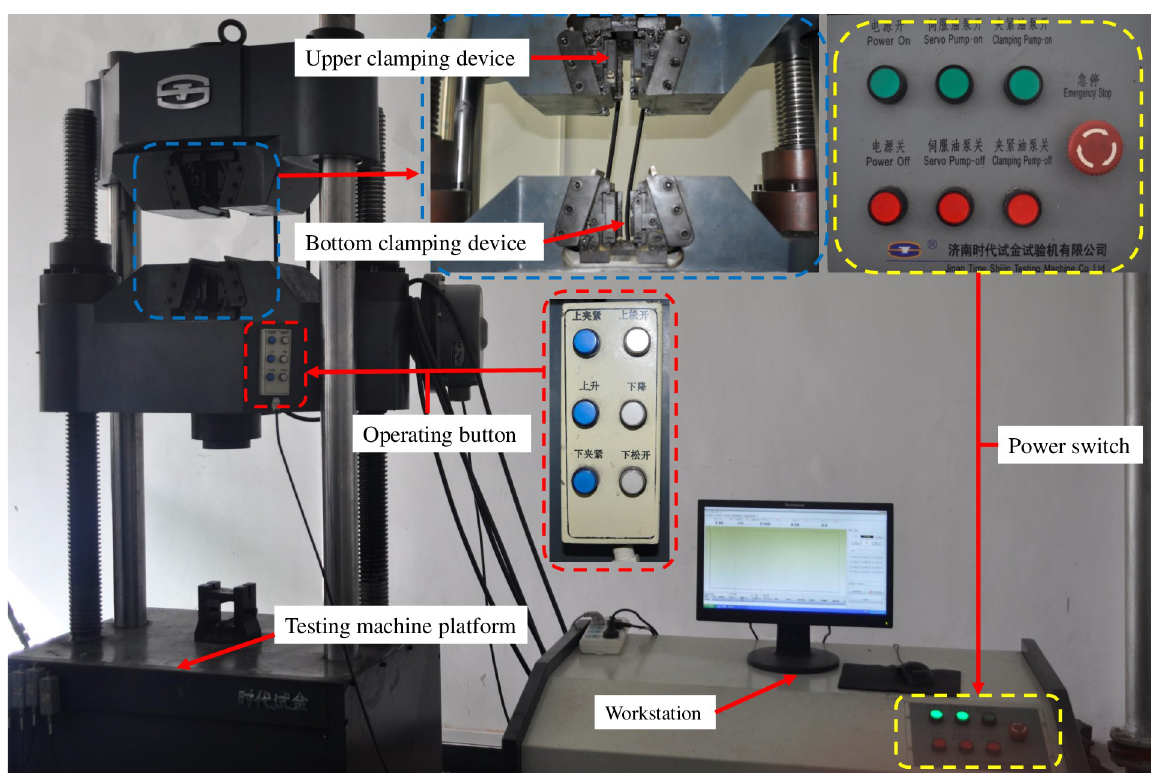
Fig 9. WAW-600C electro-hydraulic servo universal testing